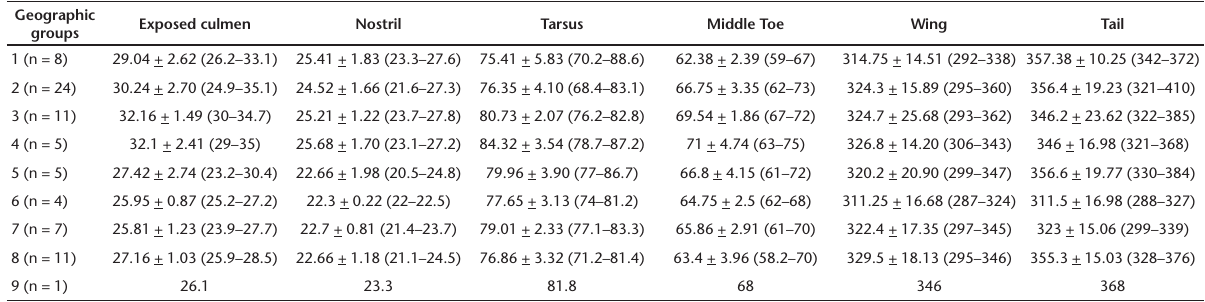
Table 2. Mean, standard deviation, minimum and maximum values of body measurements (mm) from the geographic groups of Penelope obscura .